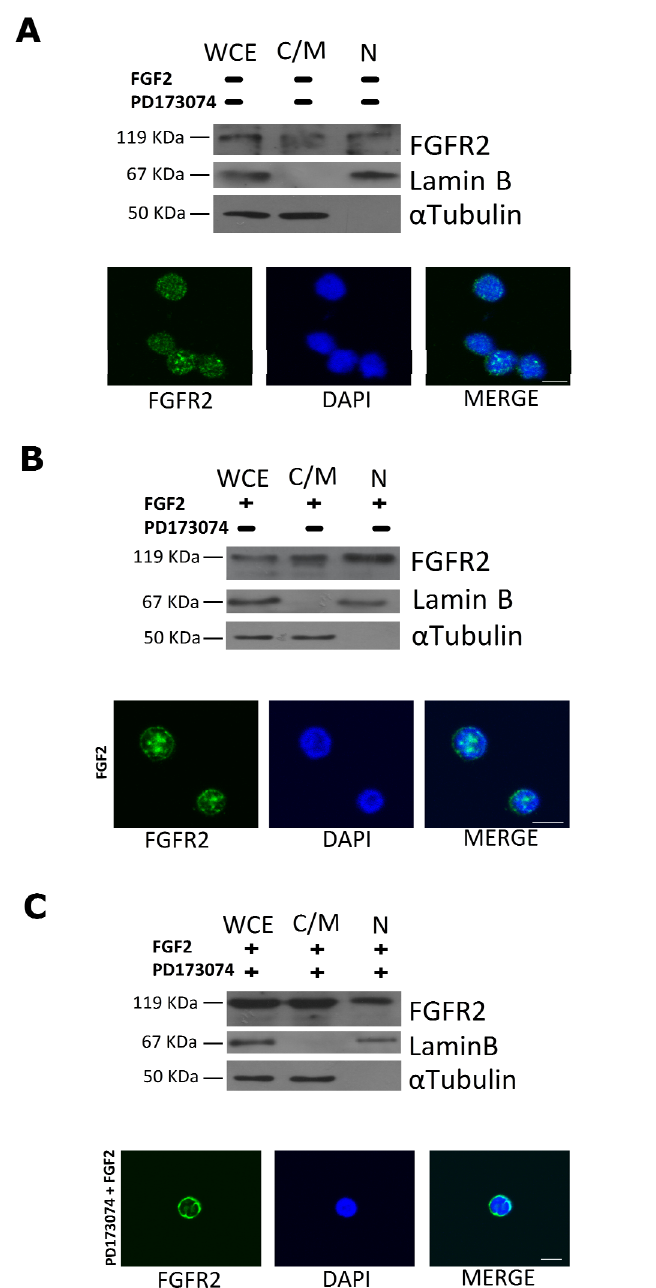
Figure 5. PD173074 inhibition affects cellular amount of FGFR2 in RS4;11 cells. RS4;11 cells were serum-starved for 12 h and preincubated for 1 h ( A ) with DMSO alone, ( B ) with DMSO and then stimulated with 0.1 ng/mL FGF2, or ( C ) with 2 µ M of PD173074 and then stimulated with 0.1 ng/mL FGF2. Thirty micrograms of cytosolic/membrane proteins (C/M) and 50 µ g of nuclear proteins (N) were analyzed by western blot with anti-FGFR2 antibody; α Tubulin and Lamin B were used as loading control of cytosolic and nuclear proteins, respectively (upper panels); whole cellular extract (WCE). Immunofluorescence was performed with an anti-rabbit CY2 antibody to evaluate the localization of FGFR2, and DAPI, for nuclear staining (bottom panels). Scale bars: 10 µ m. Consistent with these findings and with previous evidence that the binding of MLL- AF4 to the HOXA9 gene promoter depended on the nuclear availability of FGFR2 (Figures 2 and 3), we expected that an FGF2-mediated nuclear increase in p-FGFR2 would affect the MLL-AF4 chimera transactivity. Therefore, we carried out RT-qPCR analysis to evaluate